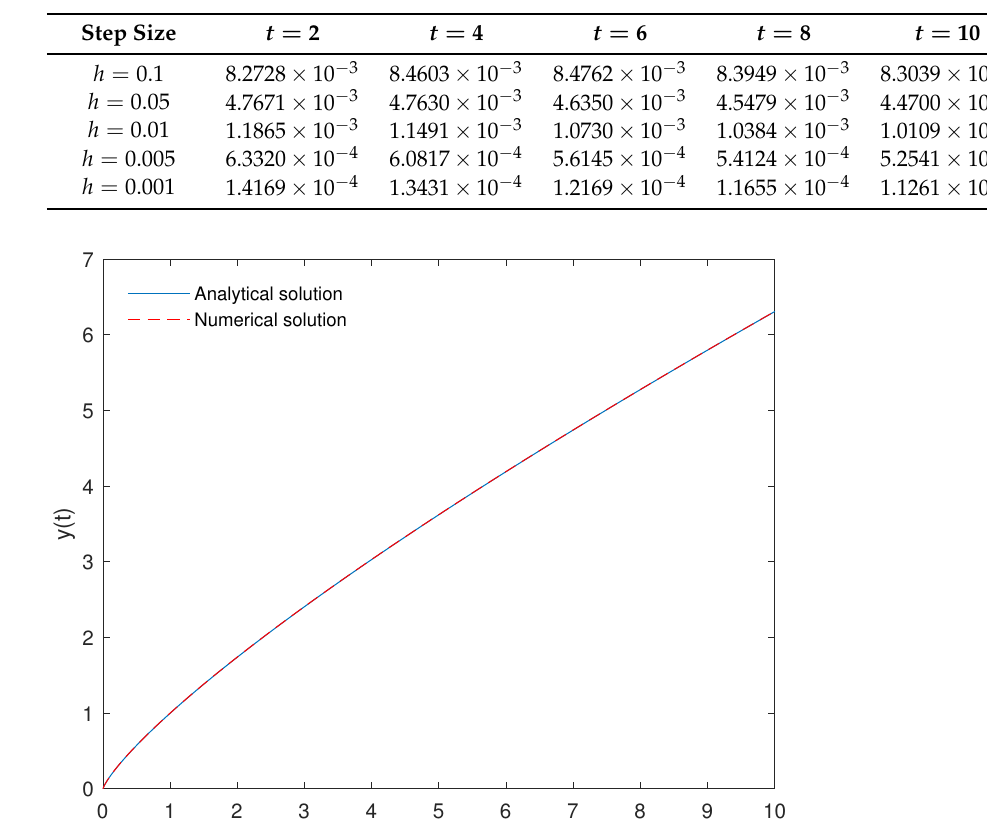
Table 1. Computation error of the time domain response of EFOTF (44).